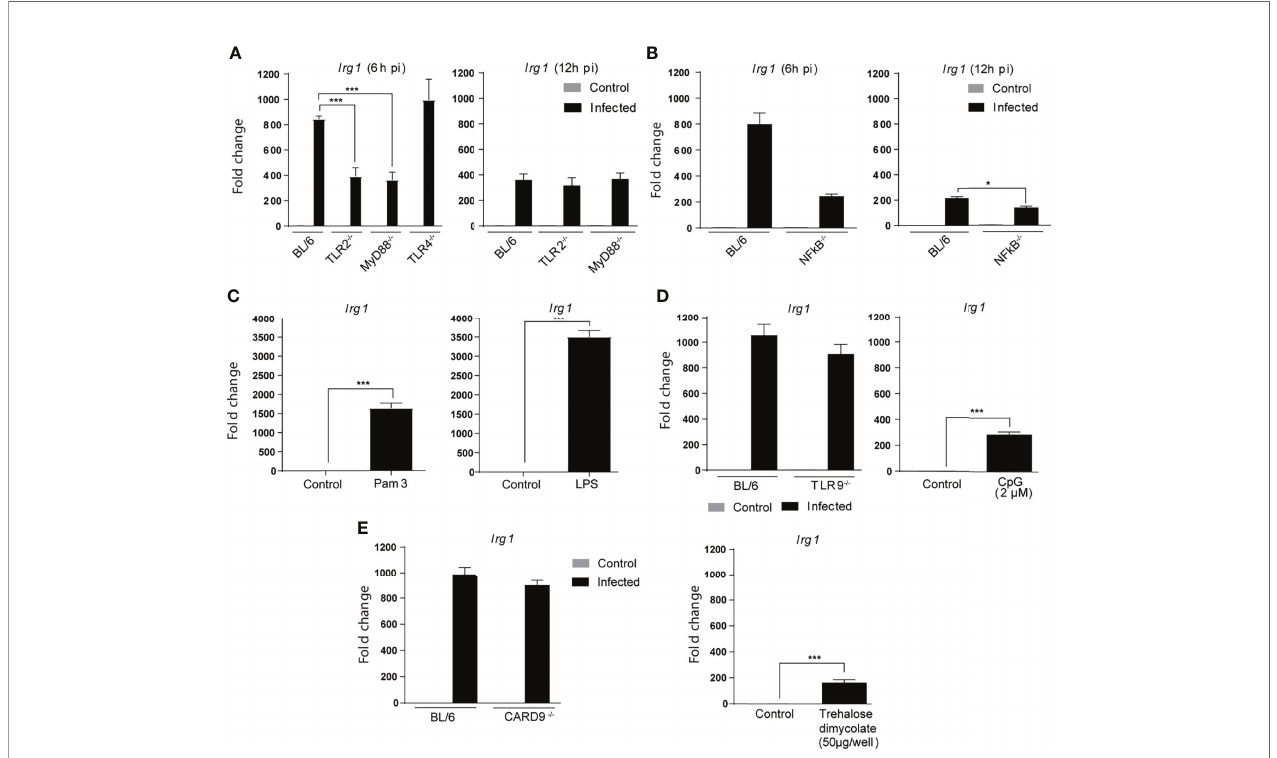
FIGURE 2 | Mtb induced Irg1 expression is partially dependent on TLR-2/MyD88/NF k B signaling. (A, B) Irg1 mRNA expression was assessed in C57BL/6, TLR-2 -/- , MyD88 -/- and TLR-4 -/- and NFkB-p50 -/- BMDM cultures following H37Rv infection at 6 h and 12 h p.i. (C) Irg1mRNA levels were evaluated in C57BL/6 BMDMs at 6 h following Pam3CSK4 (10 ng/ml) or LPS (10 ng/ml) stimulation. (D, E) Irg1 mRNA expression was assessed in BMDMs from (D) C57BL/6, TLR-9 -/- and (E) CARD9 -/- mice infected with H37Rv strain (MOI of 1) at 6 h p.i. C57BL/6 BMDMs were stimulated with (D) CpG (2 µM) or (E) trehalose dimycolate (50 µg/well) and Irg1 expression evaluated at 6 h after stimulation. As a control both CpG and trehalose dimycolate were shown to induce signi fi cant TNF- a responses when tested under the same conditions (data not shown). Signi fi cant differences are indicated as follows: *p<0.05, and ***p < 0.001. Results are representative of at least two separate experiments